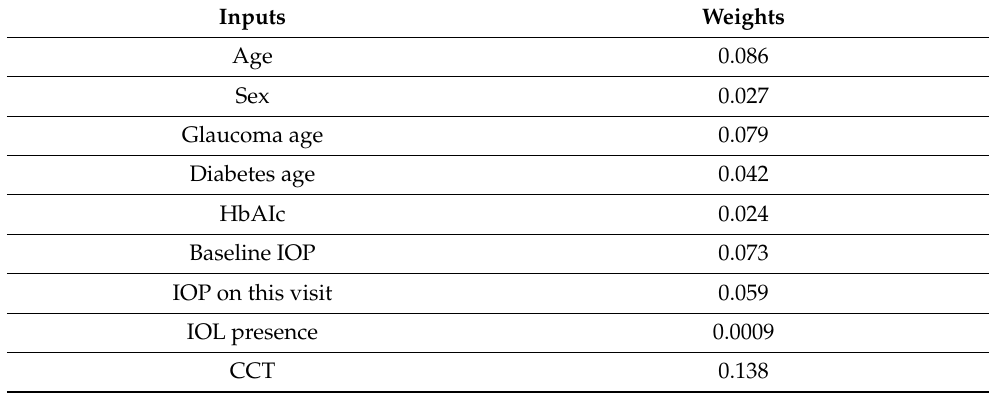
Table 6. The weights for each input in relation to the PSD output calculated with the NNGE algorithm.